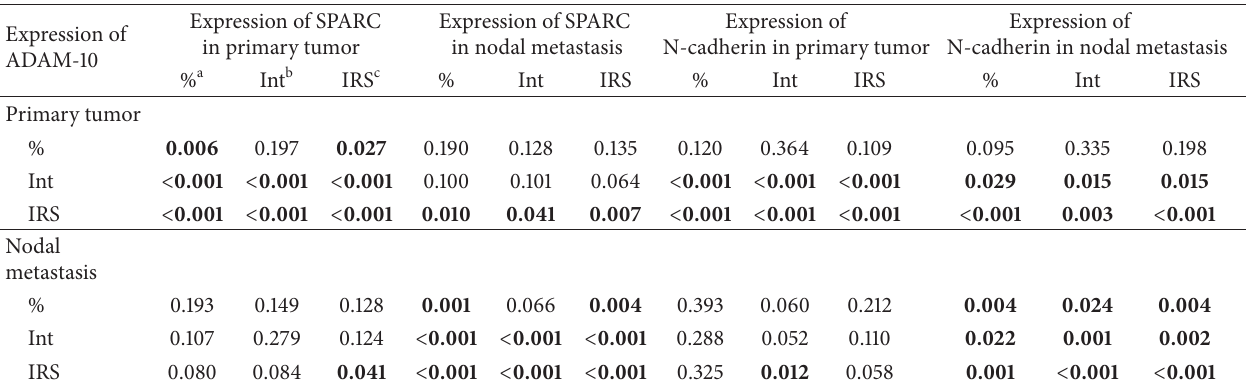
Table 4: Correlations between ADAM-10 expression parameters in primary tumors and nodal metastases and SPARC and N-cadherin immunoreactivity in melanoma cells in primary tumors and nodal